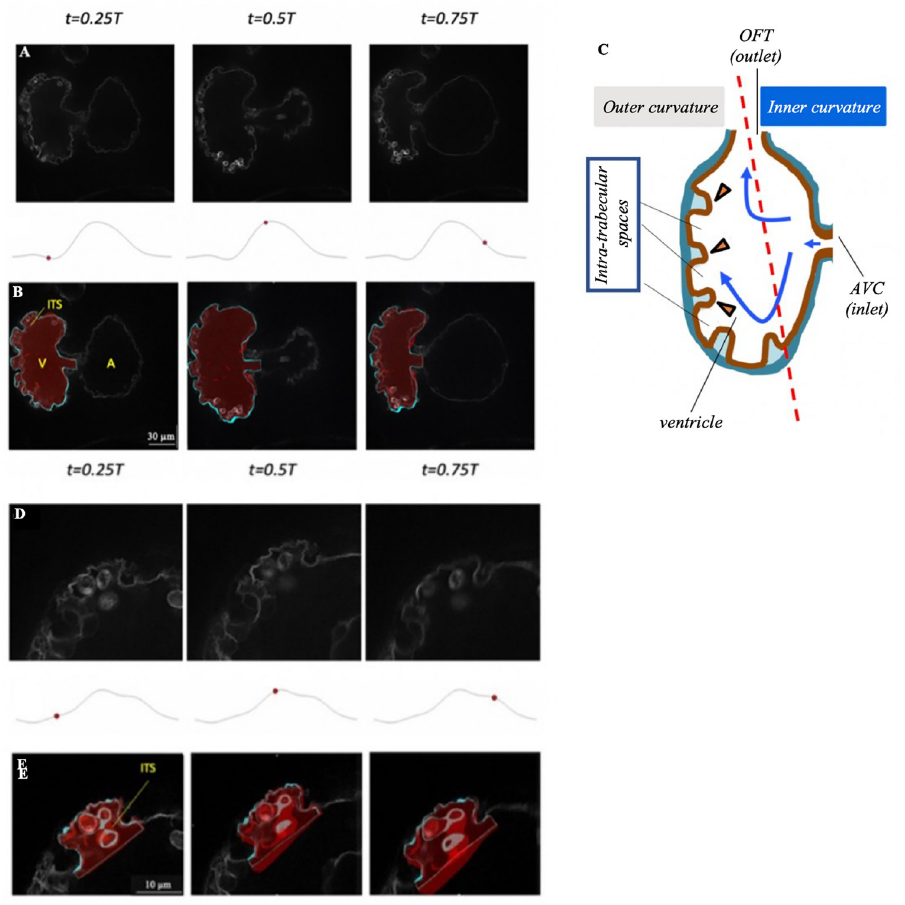
Fig 1. Microscope images and anatomic 3D models of the developing zebrafish endocardium. (A,D) Raw microscope images of (A) the whole ventricle, and (D) a single intra-trabecular space at 25%, 50% and 75% of the cardiac cycle. (B, E) Segmentation of (B) the ventricle and (E) a single intra-trabecular space, superimposed on the raw images, at the same time points as (A) and (D) (also shown in S1 Movie). The 3D reconstructed volumes are in red, while the regions of the 3D reconstruction close to the plane of the shown image are plotted in cyan on single 2D slice extracted from 4D image stacks of a zebrafish embryo from the Tg(fli1a : Gal4ff;UAS : EGFP-CAAX) line at 3 dpf. (C) Schematization of the intra-trabecular geometry, adapted from [15]. A, atrium; V, ventricle; ITS, intra-trabecular space. Here, t denotes time, while T denotes cardiac cycle duration.